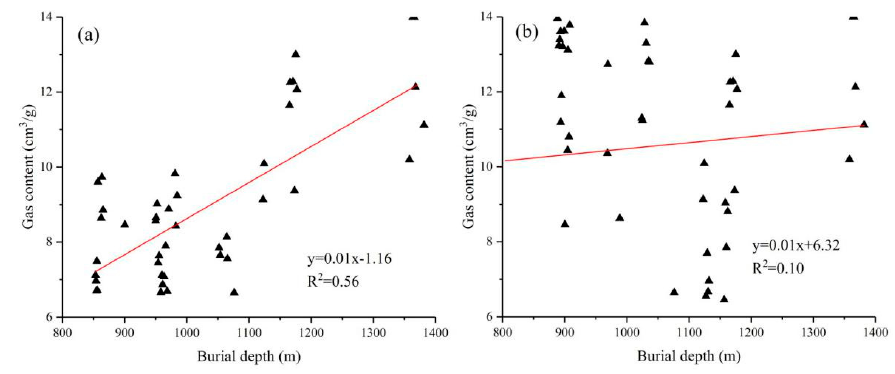
Figure 14. The fitting relationship between the gas content and buried depth of the Nos. 42, 43, 45 coal seams ( a ); fitting relationship between the gas content and buried depth of the Nos. 39, 41 coal seams ( b ).